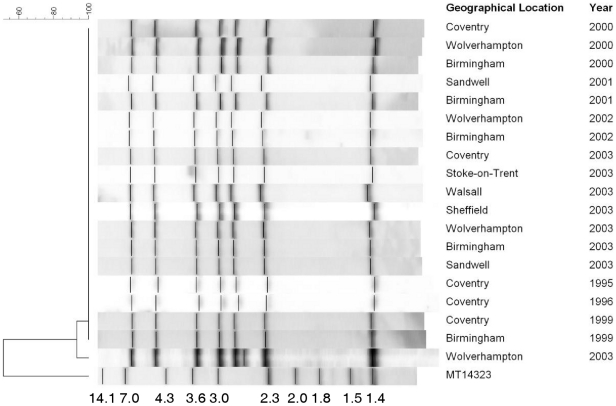
Results of RFLP analysis for isolates of the Mercian strain across the Midlands between 1995 and 2003.Each horizontal lane is an example of an individual M. tuberculosis strain from each location and year. The molecular sizes of the digested DNA fragments of MT14323 are shown in kilobases. The 8th IS6110 fragment was identified in an isolate from Wolverhampton in 2003.